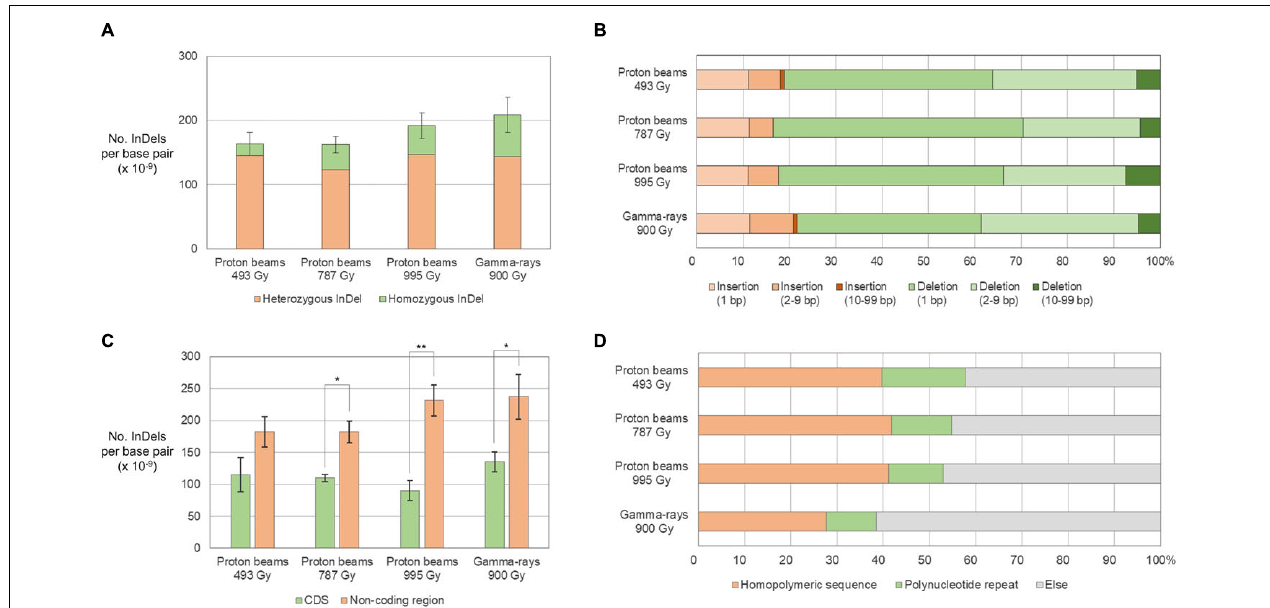
FIGURE 6 | Frequency and types of small InDels ( < 100 bp) in M 2 lines derived from proton beam and gamma-ray irradiation. (A) Frequency of small InDels classified according to zygosity. (B) Proportions of small InDels classified according to their length. (C) Frequency of small InDels classified according to their location on protein coding (CDS) and non-coding DNA regions. (D) Proportions of small InDels classified according to the surrounding repeat sequences. Asterisks indicate significance of differences between groups (* p < 0.05, ** p < 0.05 in student’s t -test). Ti/Tv is the ratio between frequency of transitions and